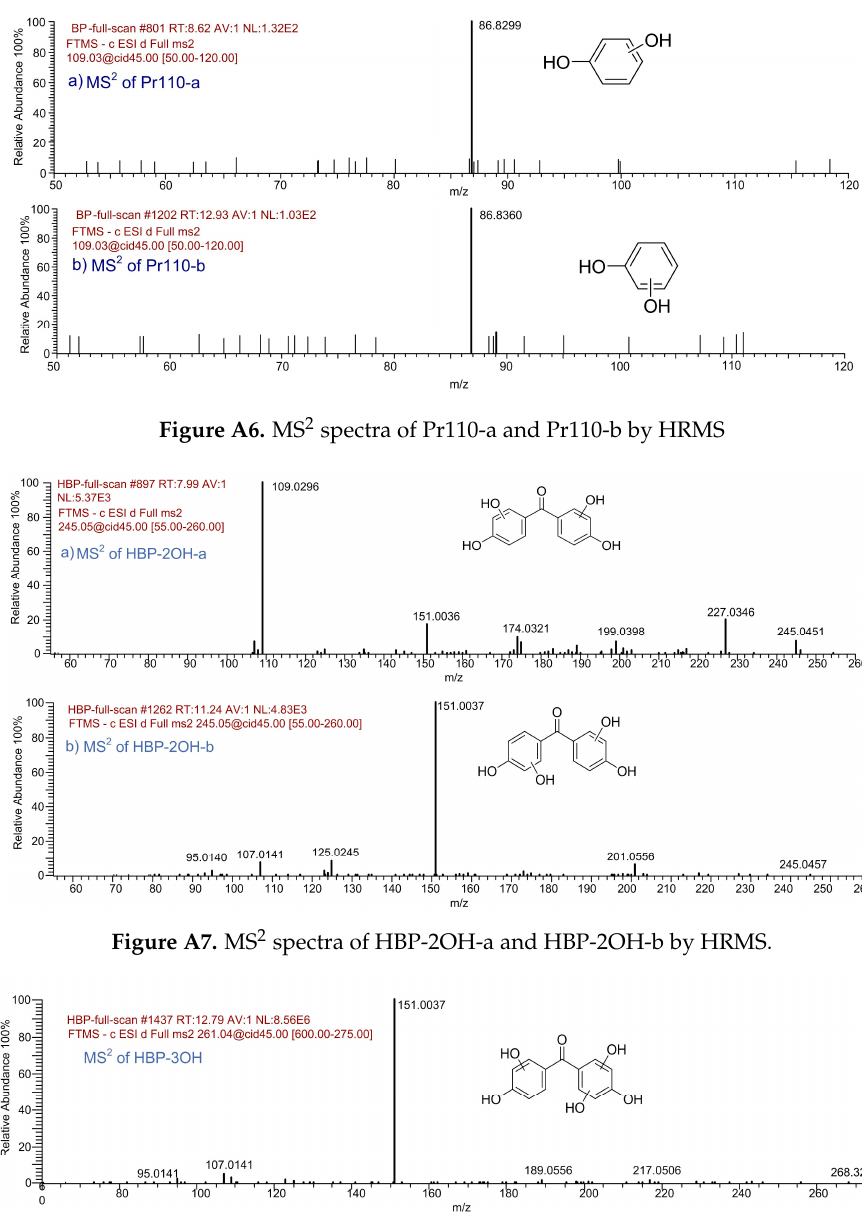
Figure A8. MS 2 spectra of HBP-3OH by HRMS.